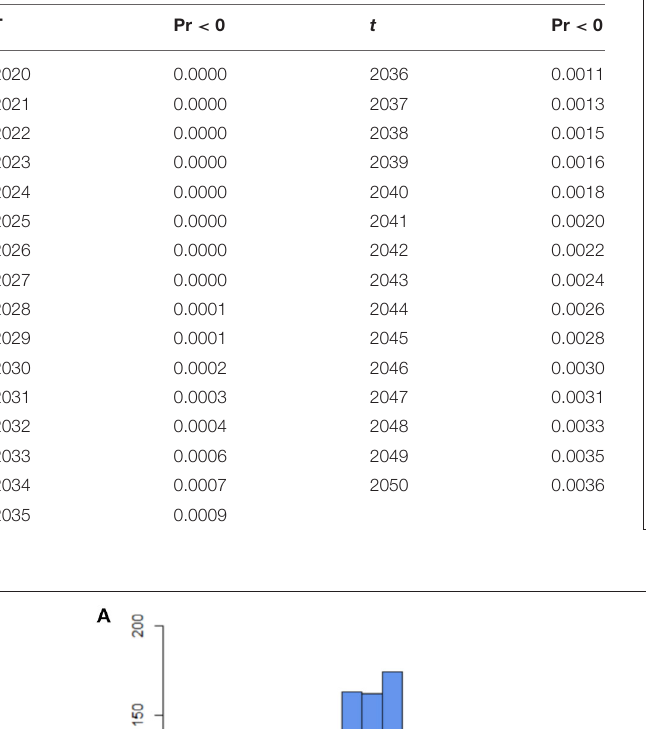
FIGURE 7 | (A) Simulation with the interest rate at t